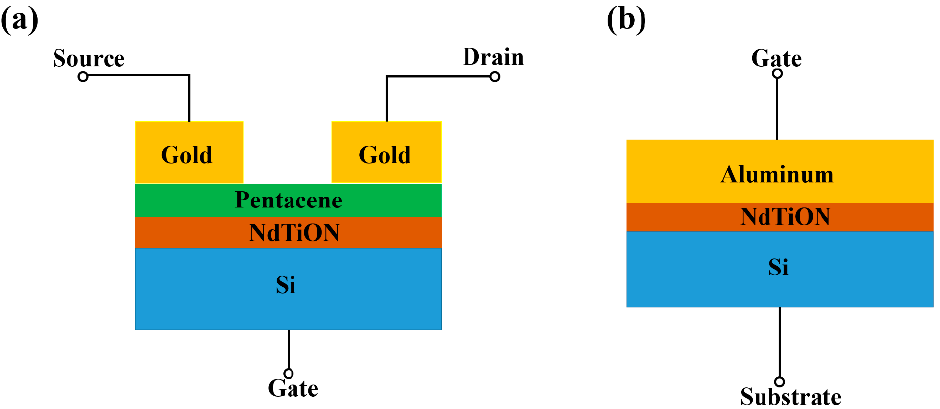
Figure 1. Device cross-section: ( a ) OTFT, and ( b ) capacitor.